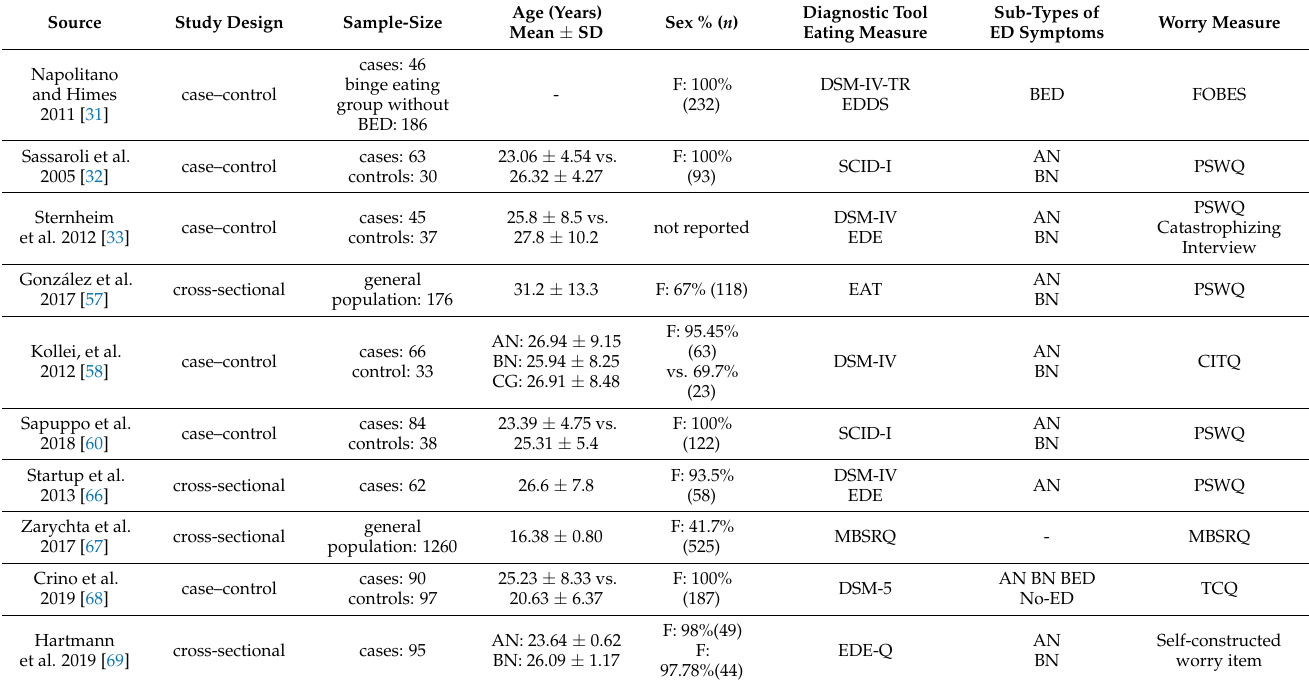
Table 1. Summary of the demographic characteristics of the studies assessed and the relationship between worry and eating